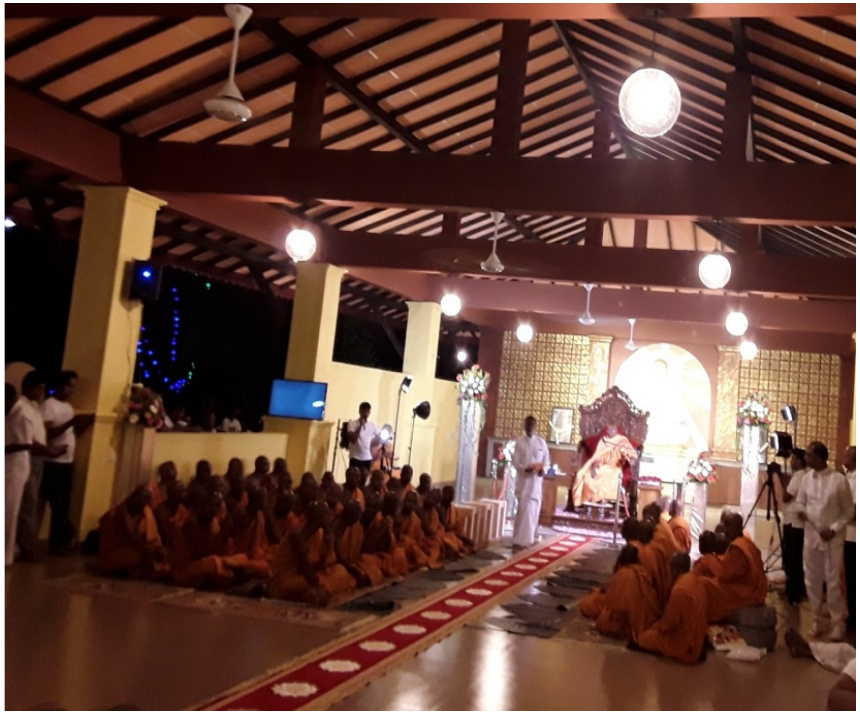
Figure 4. Samanthabhadra and his monastic disciples at the katina offering ceremony. Photo by author. 19 October 2019, Umandawa Monastery, Kurunegala.